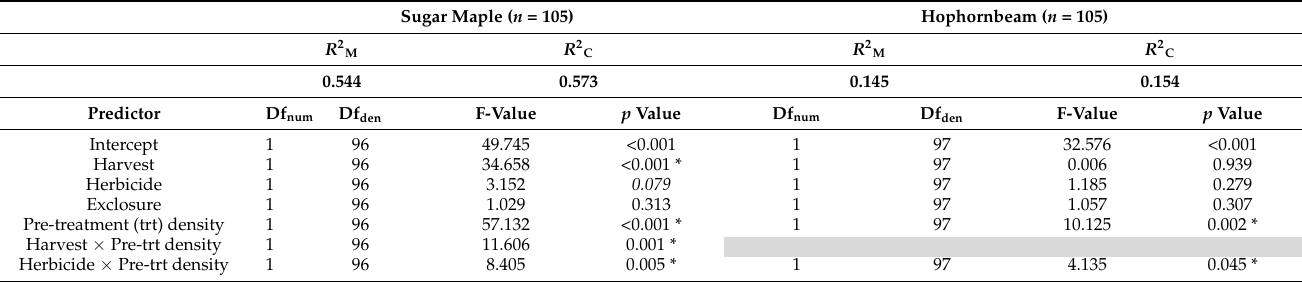
Figure 3. Mixed model regressions illustrating predicted sugar maple ( Acer saccharum Marsh.) and hophornbeam ( Ostrya virginiana ((Mill.) K. Koch) seedling (<45.7 cm tall) and sapling (>45.7 cm tall, <15.2 cm dbh) density among harvest, herbicide, and exclosure treatments in a managed northern hardwood forest in the Upper Peninsula of Michigan, USA. Regression lines falling within the gray area indicate lower 2017 density compared to 2015 density. Vertical lines indicate average measured pre-harvest density in selection (dashed) and clearcut (solid) strips. Note the different axis ranges. Table 4. Mixed model effects of harvest, herbicide, exclosure, and pre-treatment density on sugar maple and hophornbeam sapling (>45.7 cm tall, <15.2 cm dbh) density in 80.94 m 2 plots of managed northern hardwood forests in the Upper Peninsula of Michigan, USA. The site was included as a random effect. Models first included all treatment interactions and were then simplified if no inter- action effect was detected (i.e., p > 0.10). Lower order interactions were retained if higher order in- teractions were statistically significant. * Asterisks indicate statistical significance ( p < 0.05), itali- cized values indicate marginal significance (0.05 < p < 0.10). R 2M , marginal R 2 (fixed effects only); R 2C , conditional R 2 (fixed and random effects); Df num , numerator degrees of freedom; Df den , denominator degrees of freedom.